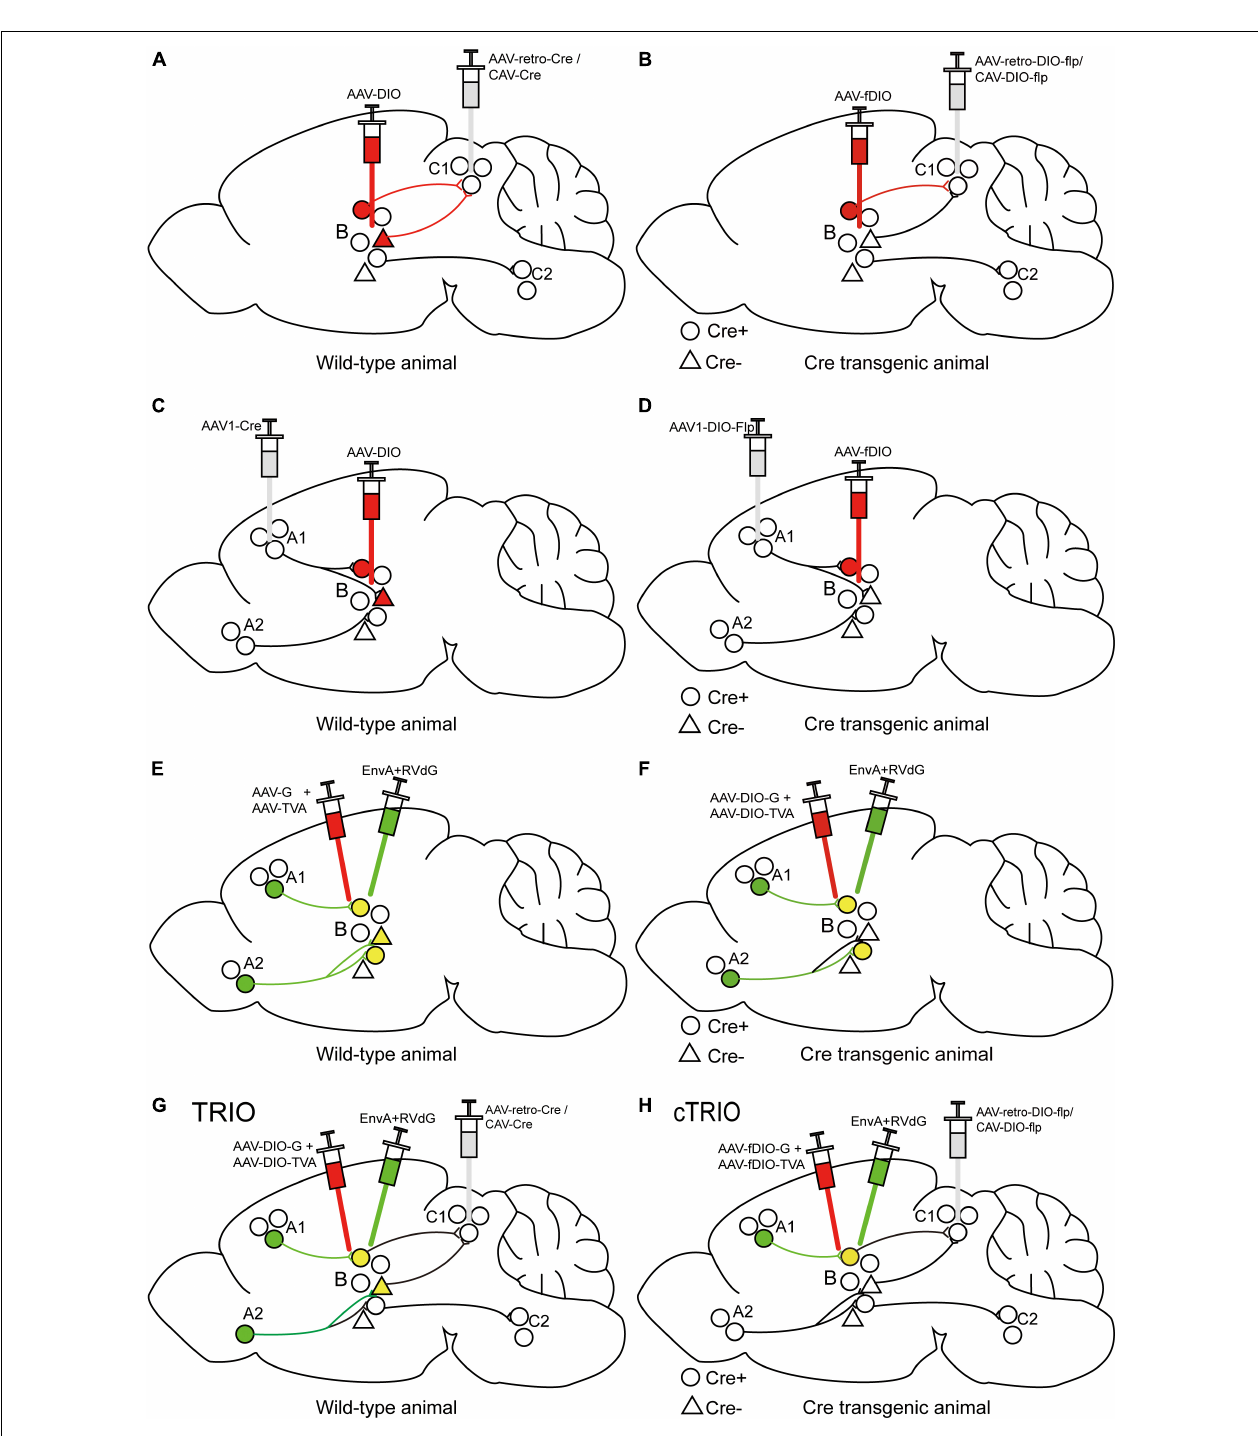
FIGURE 3 | Specific illustrations of labeling neuron subpopulations of interest with cell-type and/or projection specificity. (A) The scheme for retrograde tracing to specifically label C1-projecting B neurons. (B) The scheme for retrograde tracing combined with Cre transgenic animals to specifically label Cre-expressing neuron subpopulations in region B projecting to region C1. (C) The scheme for trans-monosynaptic anterograde tracing to specifically label B neurons receiving inputs from region A1. (D) The scheme for trans-monosynaptic anterograde tracing combined with Cre transgenic animals to specifically label Cre-expressing neuron subpopulations in region B receiving inputs from region A1. (E) The strategy for trans-monosynaptic retrograde rabies tracing to map direct presynaptic inputs onto B neurons. The starter cells (yellow) represent the co-infection of helper viruses and RVdG. (F) The strategy for Cre-dependent, trans-monosynaptic retrograde rabies tracing to map direct presynaptic inputs onto Cre-expressing B neurons. (G) The TRIO strategy to map direct presynaptic inputs onto C1-projecting B neurons. (H) The cTRIO strategy to map direct presynaptic inputs onto C1-projecting, as well as Cre-expressing B neurons.